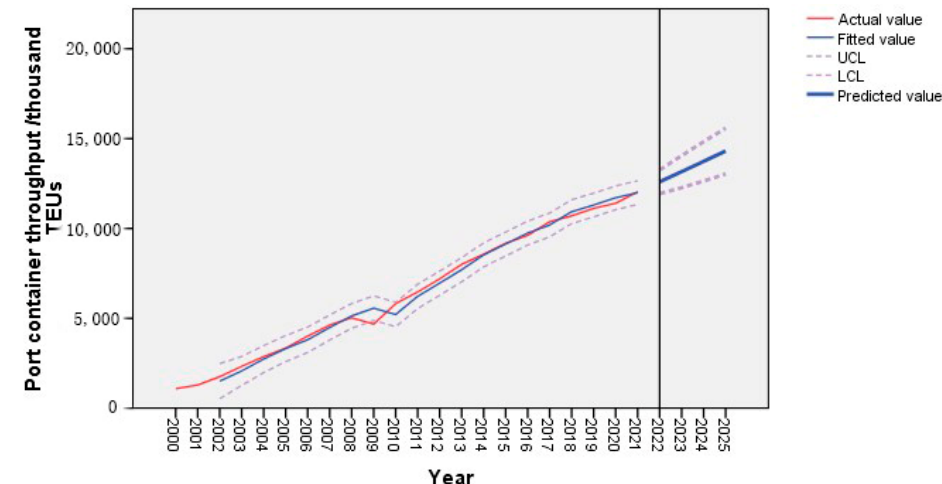
Figure 4. Cargo throughput forecast for Xiamen Port from 2022 to 2025.